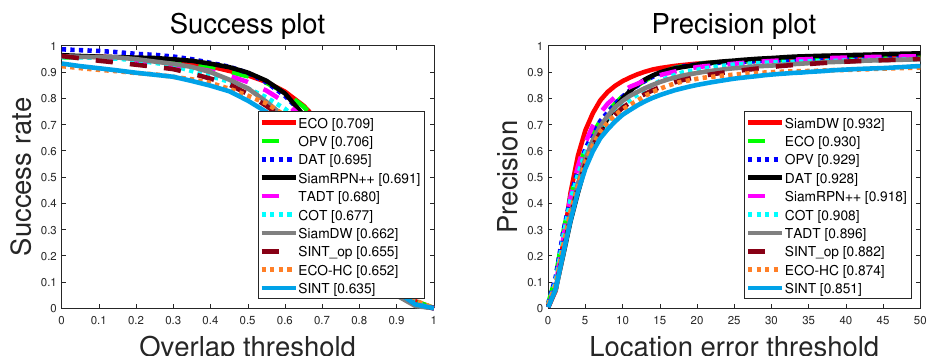
Figure 3. Quantitative comparison on deep learning-based methods using the OTB dataset. We com- pared the proposed method (OPV) with SIAMese network Deeper and Wider (SiamDW), SIAMese Region Proposal Network (SiamRPN++), Siamese INstance search Tracker (SINT), Deep Atten- tive Tracking (DAT), Target-Aware Deep Tracking (TADT), Efficient Convolution Operators (ECO), and Continuous Convolution Operator Tracker (C-COT). Table 4. Quantitative comparison using our unmanned aerial vehicle (UAV) datasets. The best results are indicated in bold type. SiamRPN++ DAT